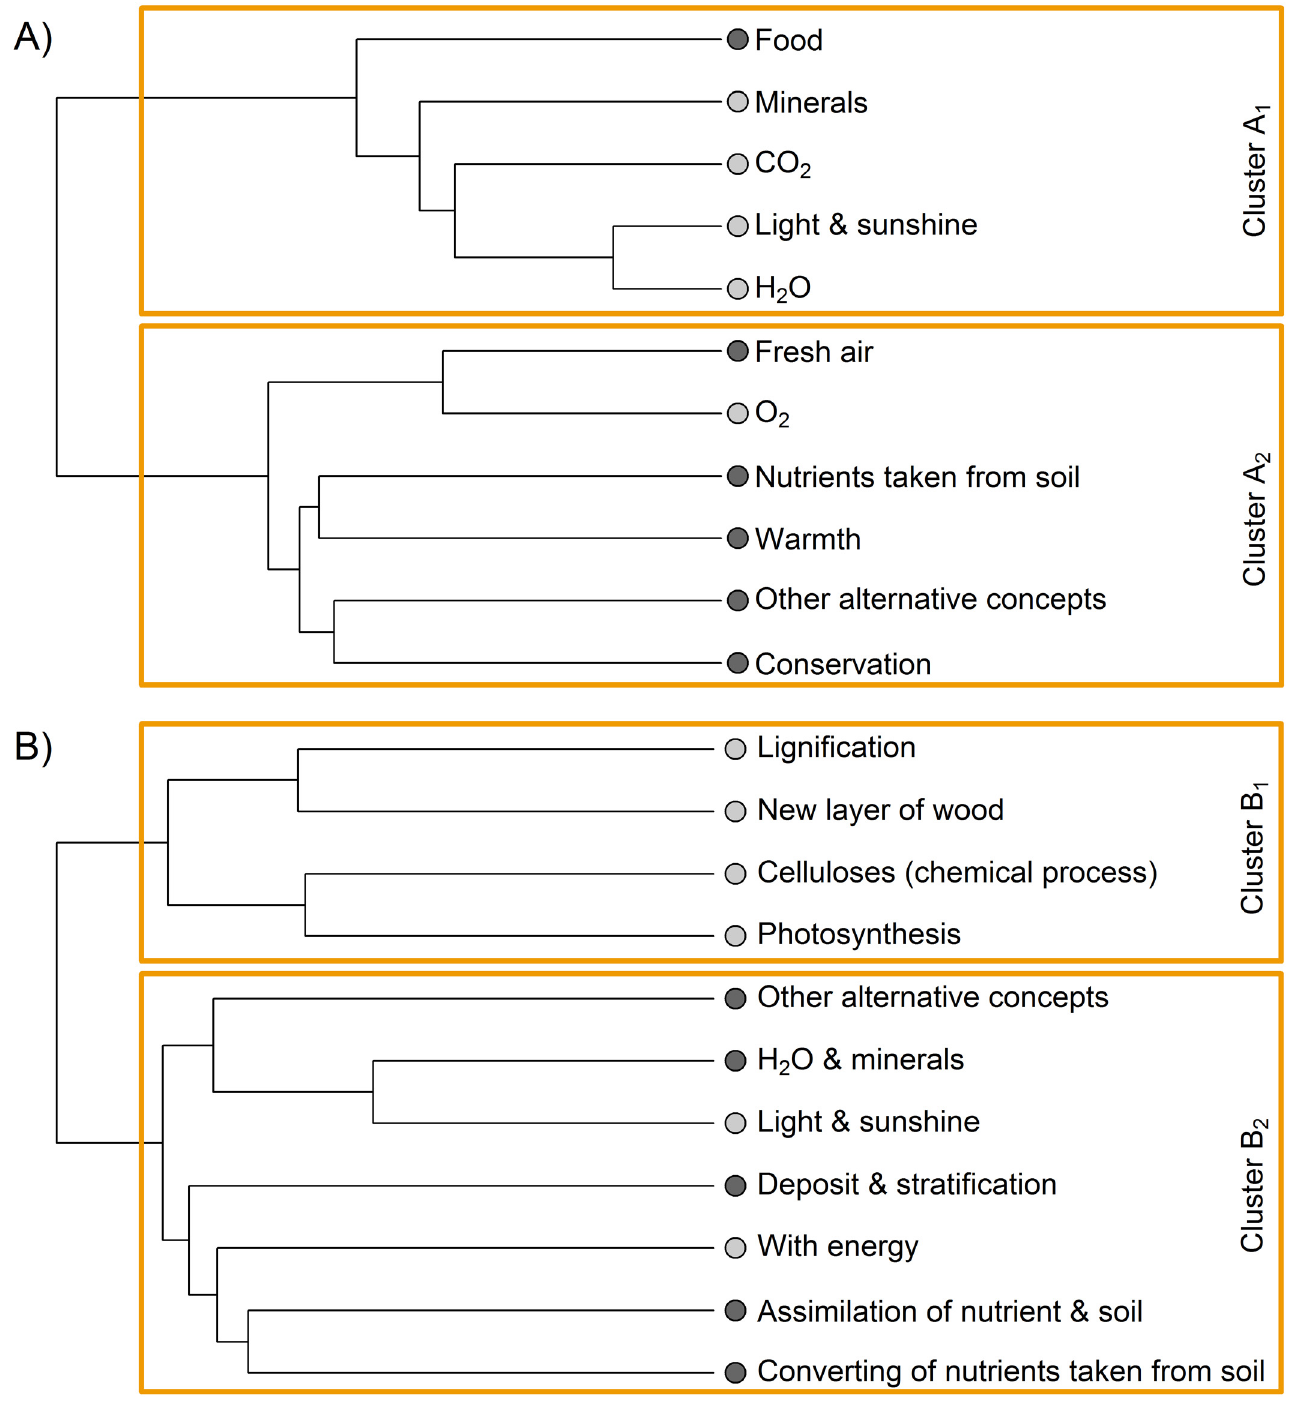
Fig 1. Cluster analysis (based on ward´s method and k-mean procedure) for co-existence of scientific (light grey) and alternative (dark grey) conceptions (N = 885).